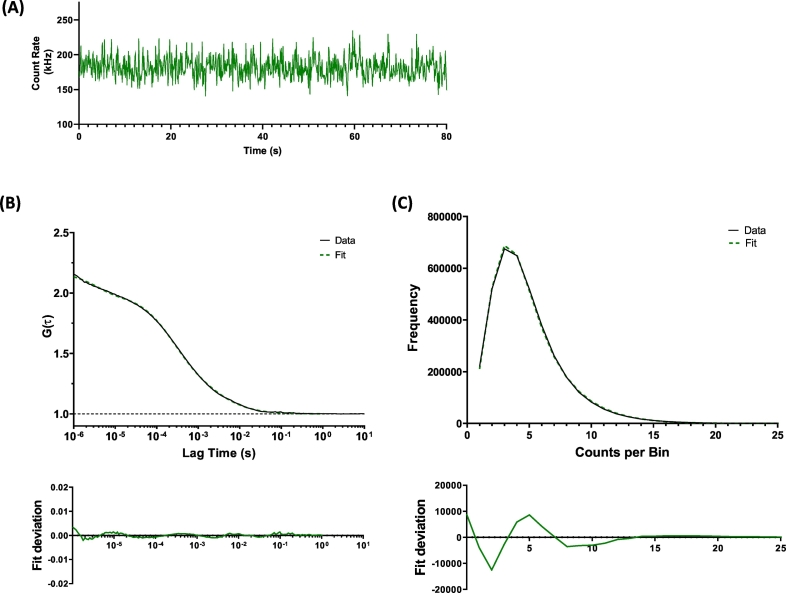
Fluorescence correlation spectroscopy and photon counting histogram analysis of SMALP-purified ABCG2-GFP. SMALPs containing ABCG2-GFP were prepared in assay buffer as described in Methods, and FCS measurements were obtained from 150 μL of sample as described in Methods. (A) Fluorescence fluctuation traces were obtained using 488 nm excitation and analysed by either autocorrelation (AC) analysis or photon counting histogram (PCH) analysis. (B) Autocorrelation curves (upper) were best fit by a 2-component 3D diffusion model (residuals shown in lower) to obtain an average dwell time and particle number of ABCG2-GFP SMALPs, from which a diffusion coefficient and concentration could be calculated. (C) PCH analysis of the same fluctuations (upper) using a 20 μs bin time could be fit (residuals, lower) to obtain a value for the molecular brightness of the ABCG2-SMALPs. Data shown is an example read and analysis of a single sample, representative of those described in Table 2.